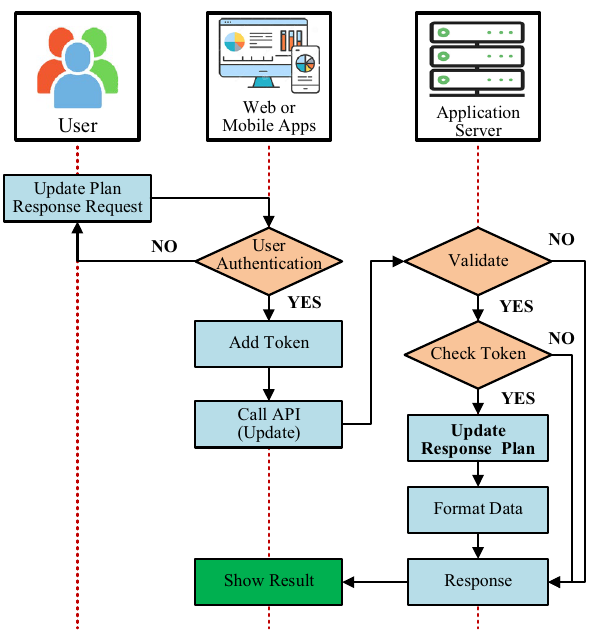
Figure 12. Flowchart of radiation incident control and update